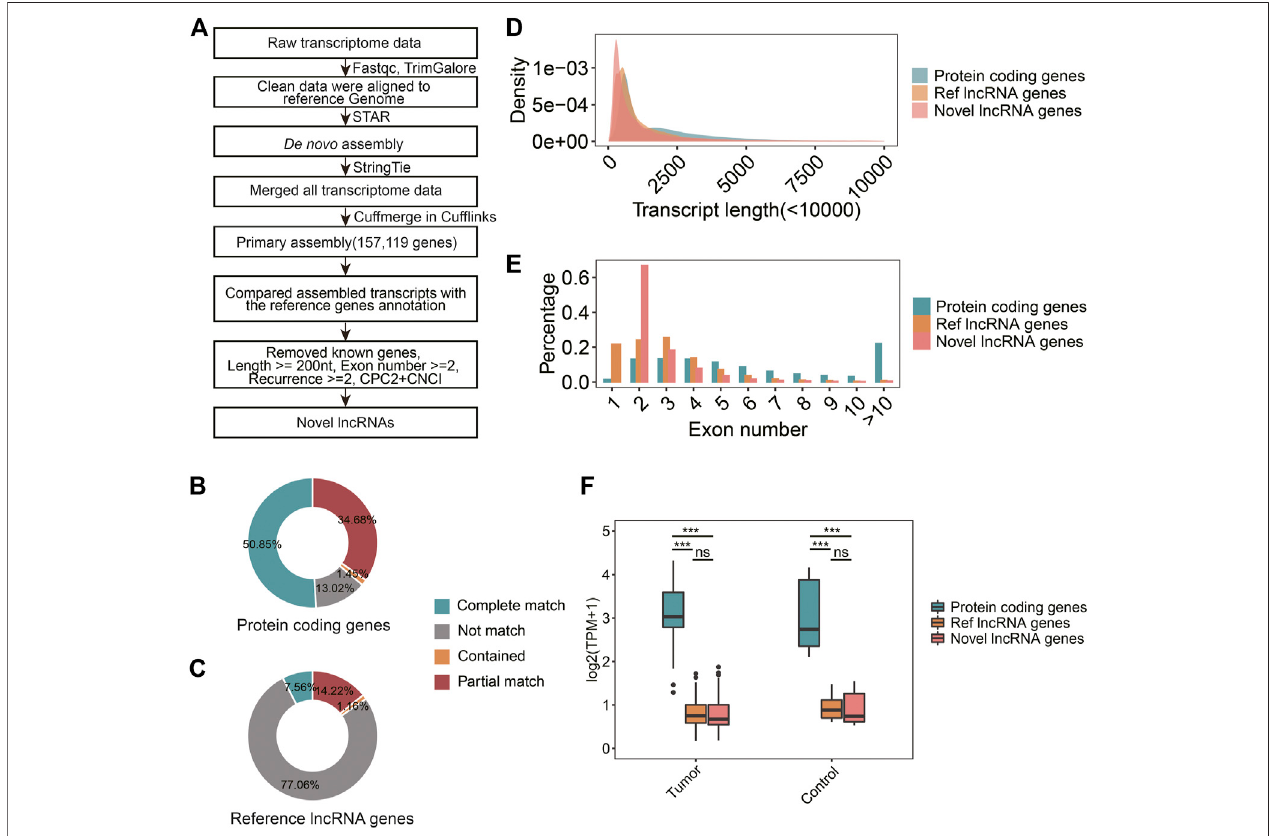
FIGURE 2 | Identi fi cation and characterization of novel lncRNA. (A) The identi fi cation process of novel lncRNAs. (B) The statistics of assembled transcripts matched to GENCODE v38 genes annotation. (C) The statistics of assembled transcripts matched to RefLncRNA genes annotation. (D) Density diagrams showed the transcript length in protein-coding genes, reference lncRNAs, and novel lncRNAs (E) Bar plot showed exon numbers in protein-coding genes, reference lncRNAs, and novel lncRNAs. (F) Boxplot showed transcript expression levels of protein-coding genes, reference lncRNAs, and novel lncRNAs in tumors and controls.